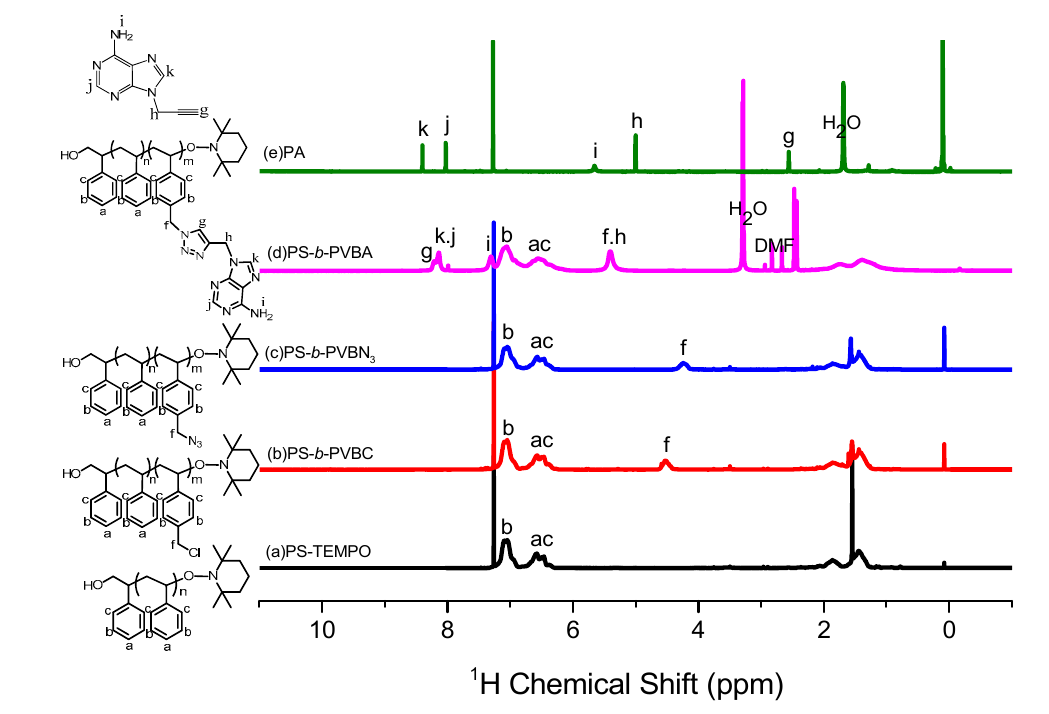
Figure 1. 1 H NMR spectra of ( a ) PS-TEMPO, ( b ) PS- b -PVBC, ( c ) PS- b -PVBN 3 , ( d ) PS- b -PVBA, and ( e ) PA.